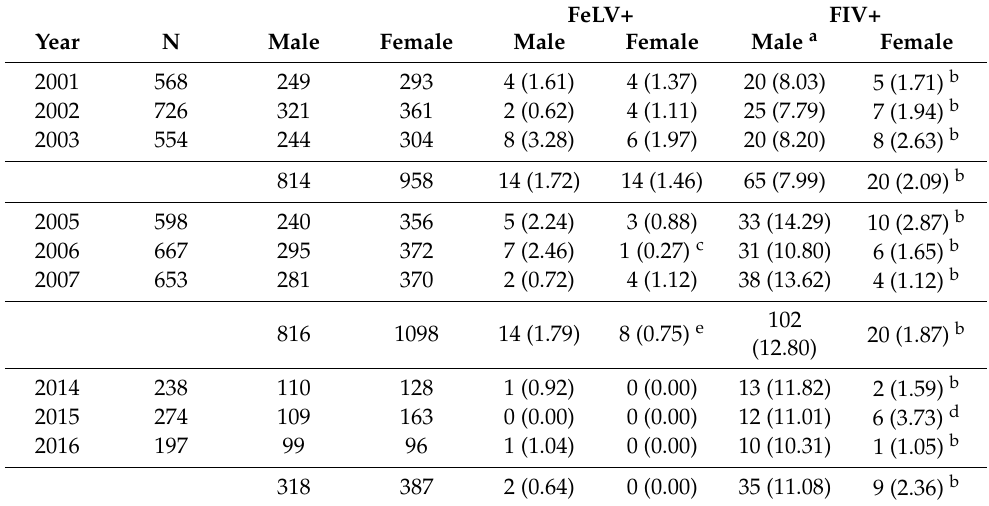
Table 3. Feline retroviral prevalence, stratified by sex, among feral cats presented to the